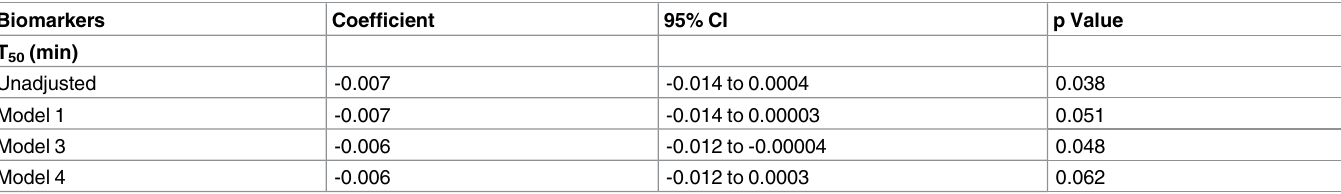
Table 4. Associations of T 50 with vascularlesions in kidney allograft recipients (n = 129), univariate and multivariate linear regression analysis.